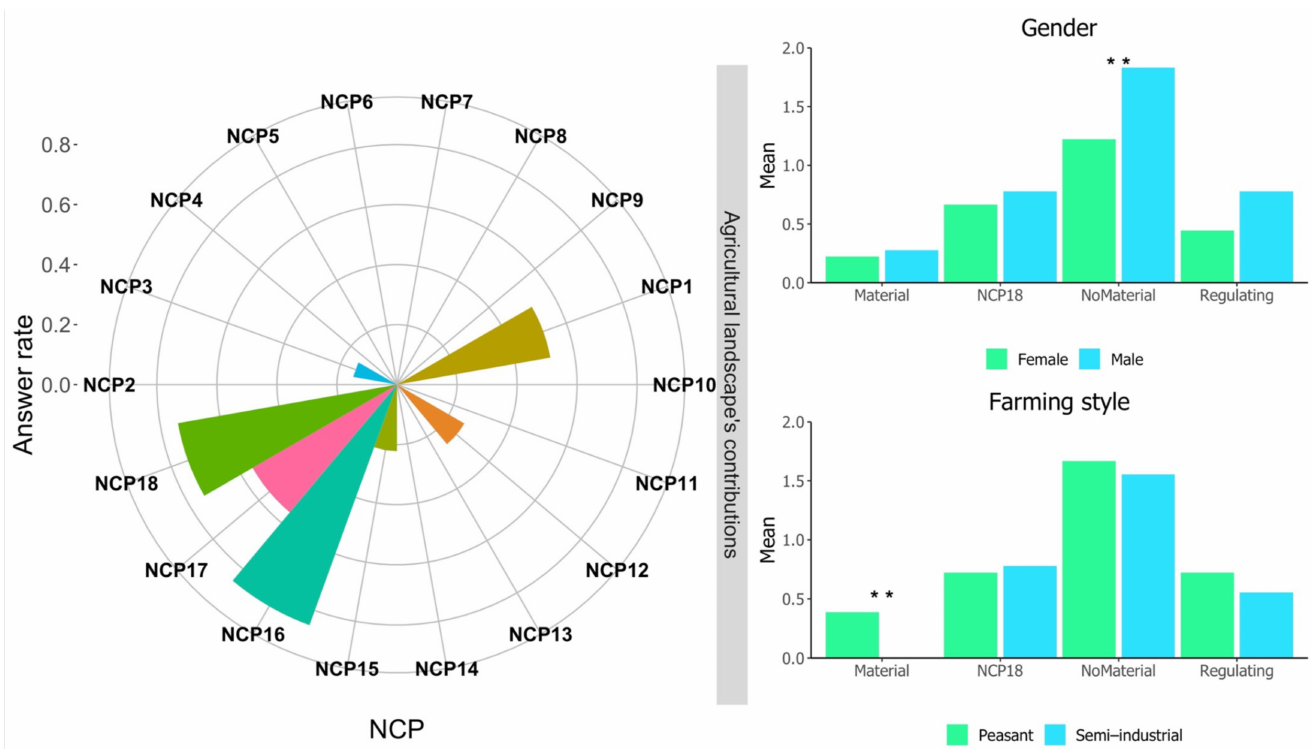
Figure 7. Farmer’s perception of NCP provided by farms in the CCLC. NCP1, habitat creation and maintenance; NCP2, pollination and dispersal of seeds and other propagules; NCP3, regulation of air quality; NCP4, regulation of climate; NCP5, regulation of ocean acidification; NCP6 regulation of freshwater quantity, location, and timing; NCP7, regulation of freshwater and coastal water qual- ity; NCP8, formation, protection, and decontamination of soils and sediments; NCP9, regulation of hazards and extreme events; NCP10, regulation of detrimental organisms and biological pro- cesses; NCP11, energy; NCP12, food and feed; NCP13, materials, companionship, and labor; NCP14, medicinal, biochemical, and genetic resources; NCP15, learning and inspiration; NCP16, physi- cal and psychological experiences; NCP17, supporting identities; NCP18, maintenance of options. Signification of codes: 0.1,